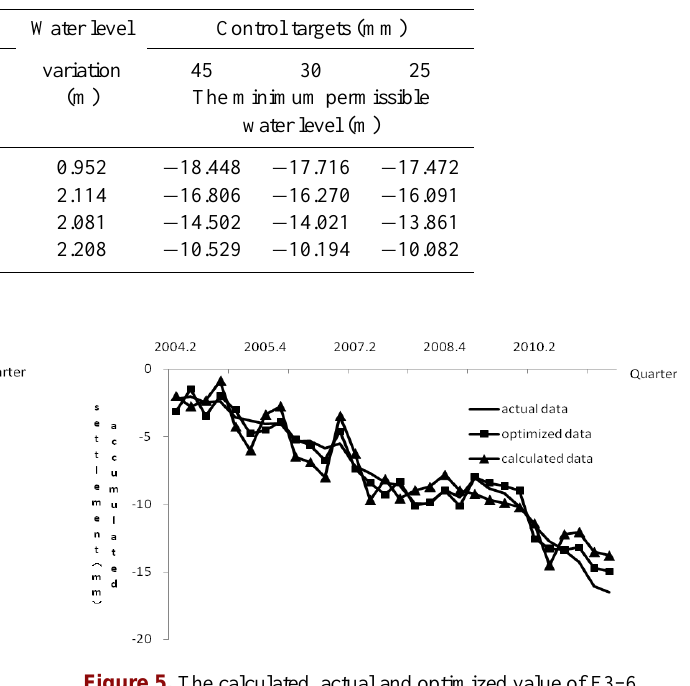
Figure 3. The calculated, actual and optimized value of F3–3.